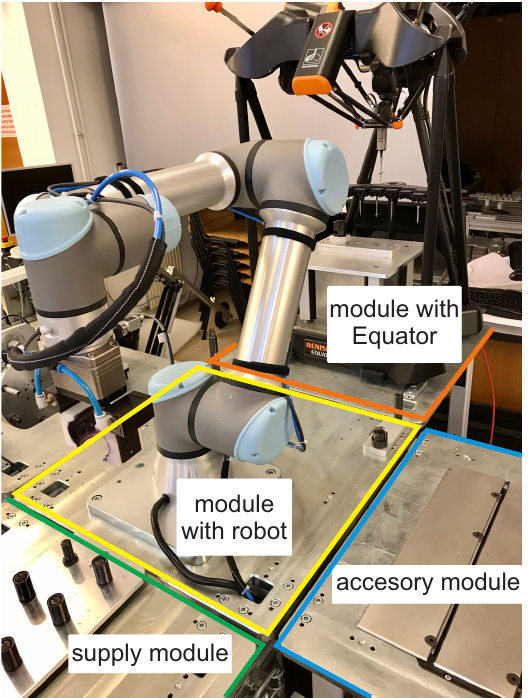
Figure 2. The subset of the adaptive robotic cell used in the study (bottom-left supply module, a module with the robot in the center, and a module with the Equator at the back). The robot hand is equipped with a Weiss Robotics two-finger gripper equipped with custom fingers, suitable for measured